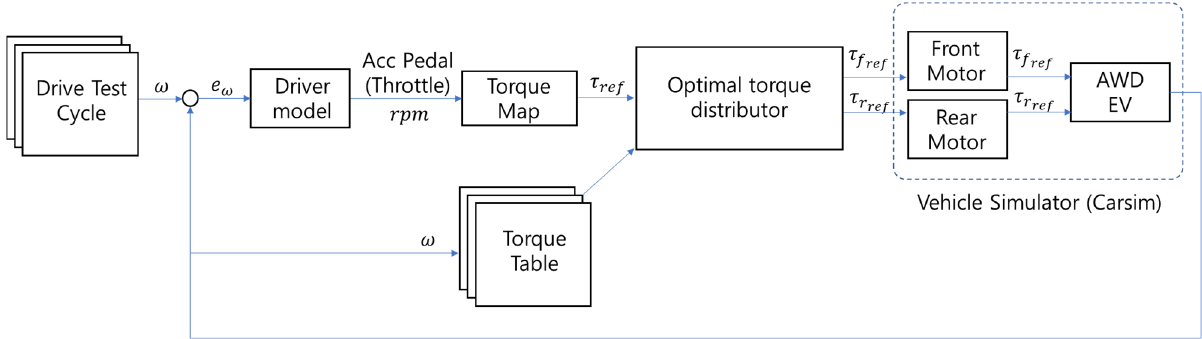
Figure 1. Simulation structure overview for TMS system configuration and verification.